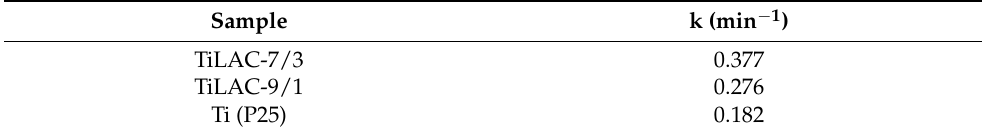
Table 4. The rate constant k values for P25 and the TiLAC composites.